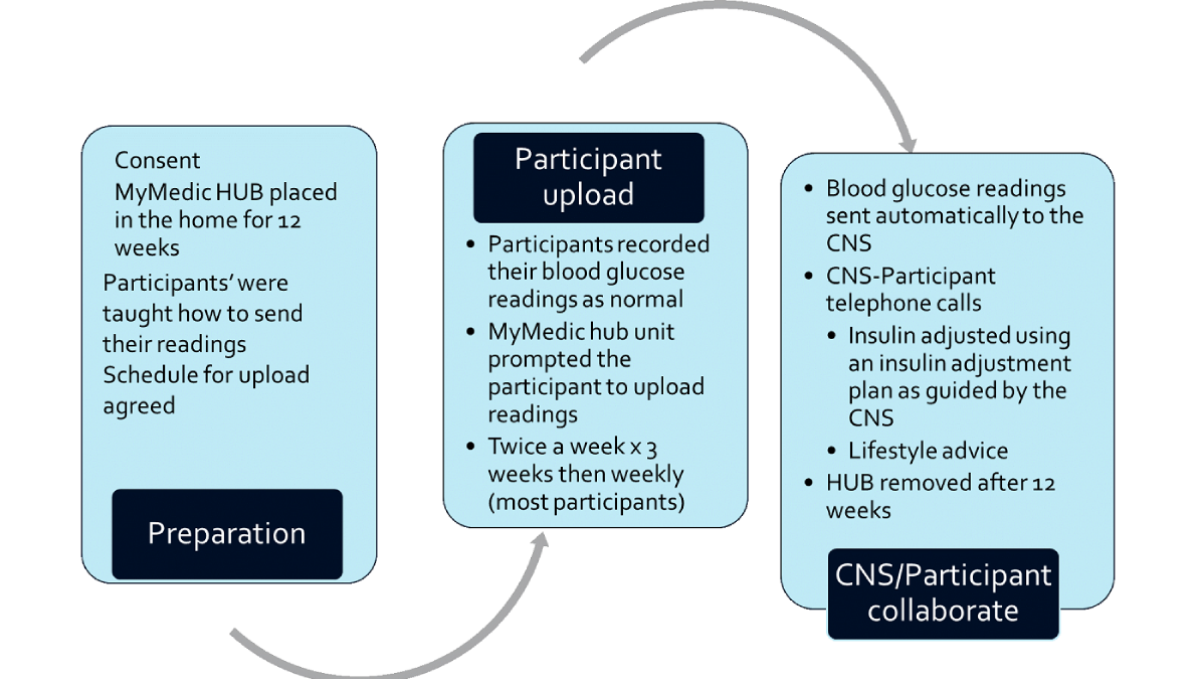
Figure 2. Intervention. CNS: clinical nurse